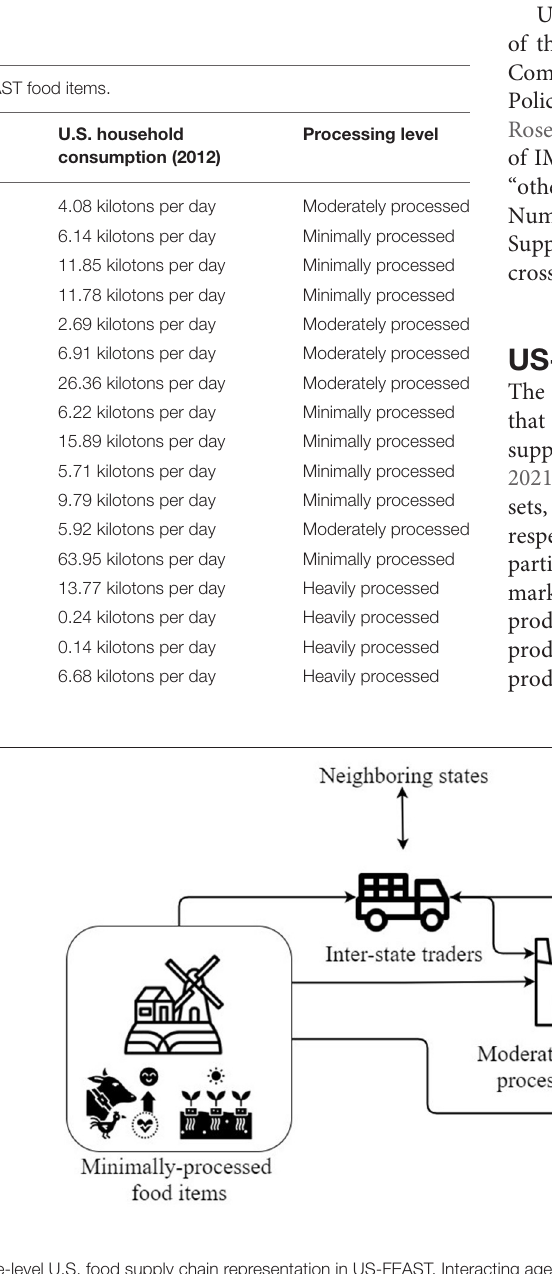
FIGURE 1 | State-level U.S. food supply chain representation in US-FEAST. Interacting agents in the US-FEAST food model are profit maximizers, while consumers decide based on their preferences. We simplify or treat as exogenous additional features across the food supply chains and food system, from production to waste and